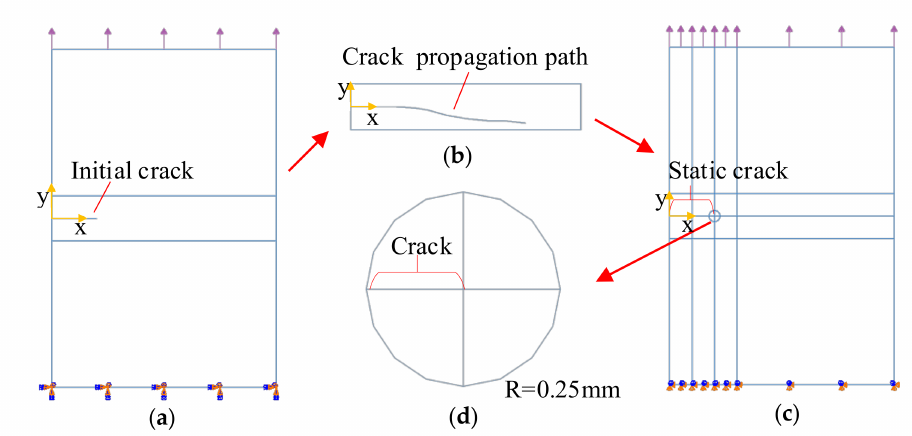
Figure 5. Finite element model of welded joint. ( a ) XFEM model, ( b ) the local view of crack propagation path, ( c ) static crack model, and ( d ) the local view of crack